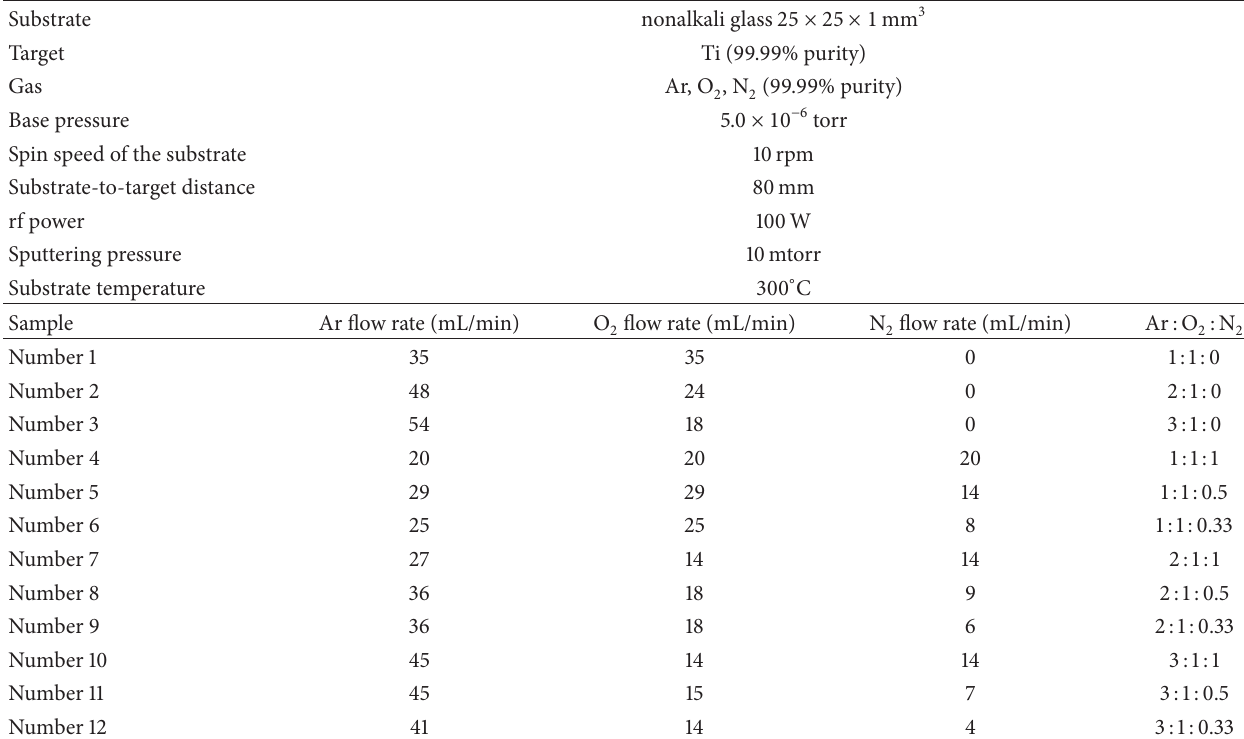
Table 1: The deposition conditions for TiO